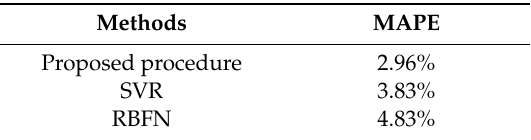
Table 2. Forecasting performances of various methods.